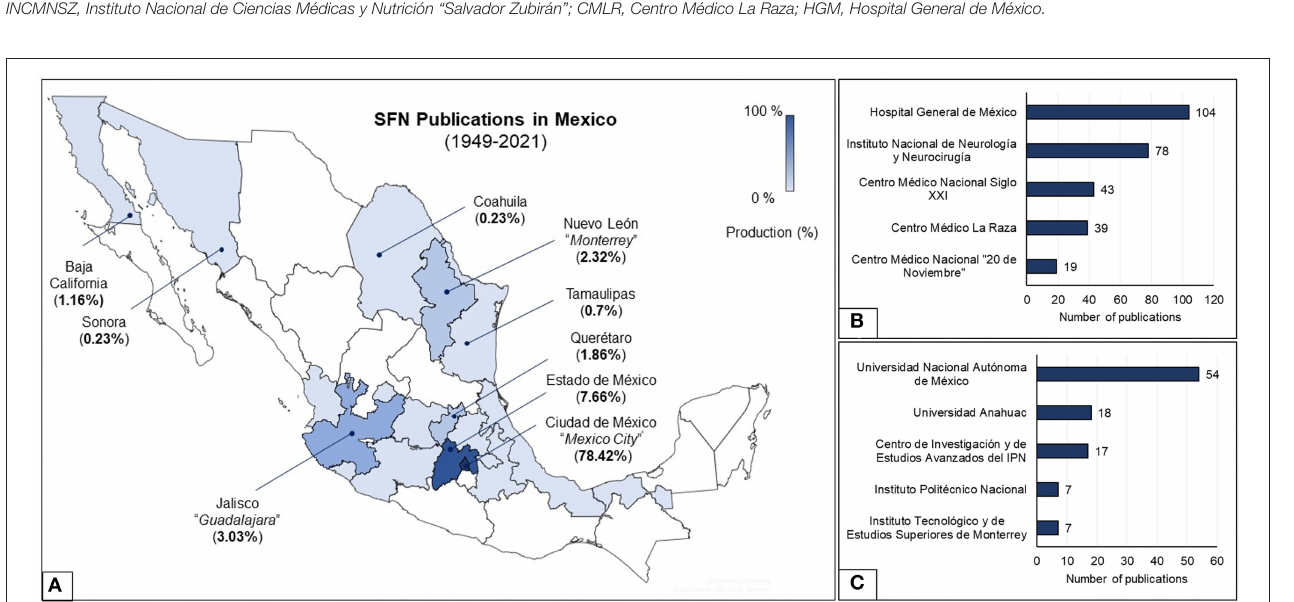
with Alonso-Vanegas making advances on translational research in epilepsy (36), and Revuelta describing the effectiveness of surgical decompression for trigeminal neuralgia